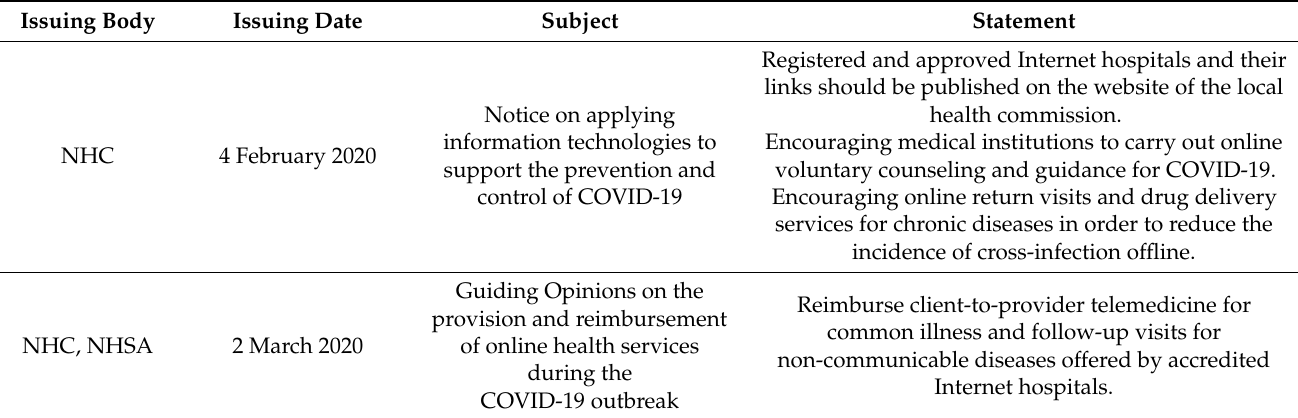
Table A2. Internet hospital policies issued during COVID-19 (national level)